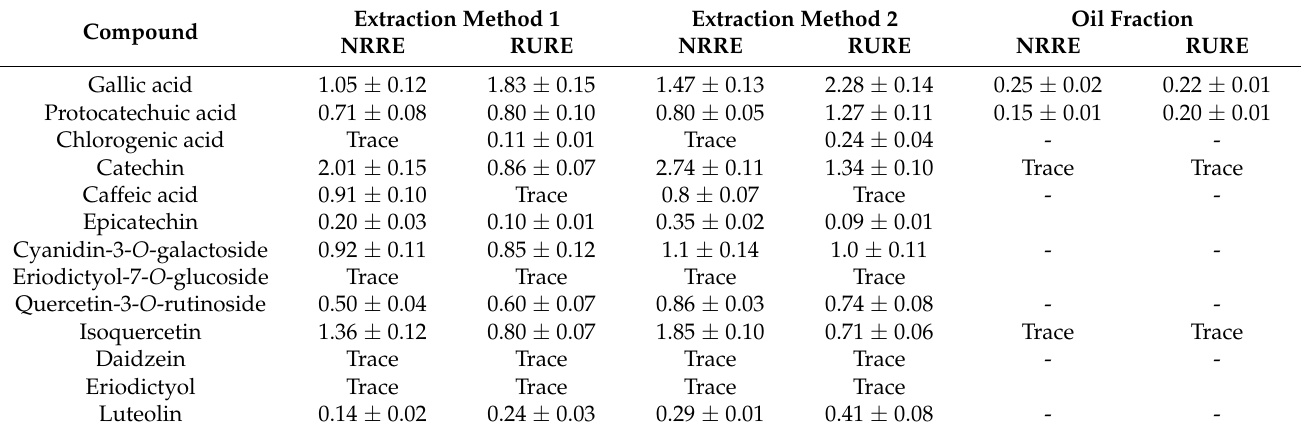
Table 1. Polyphenolic composition of the pistachio extracts. Results are expressed as mg/100 g and represent the mean of triplicate determinations ±